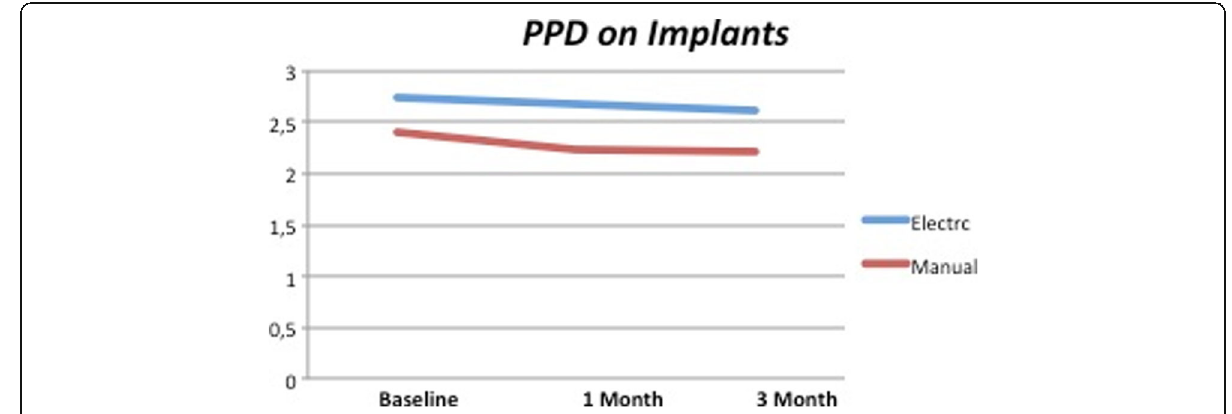
Fig. 7 PPD on dental implants. No significant differences